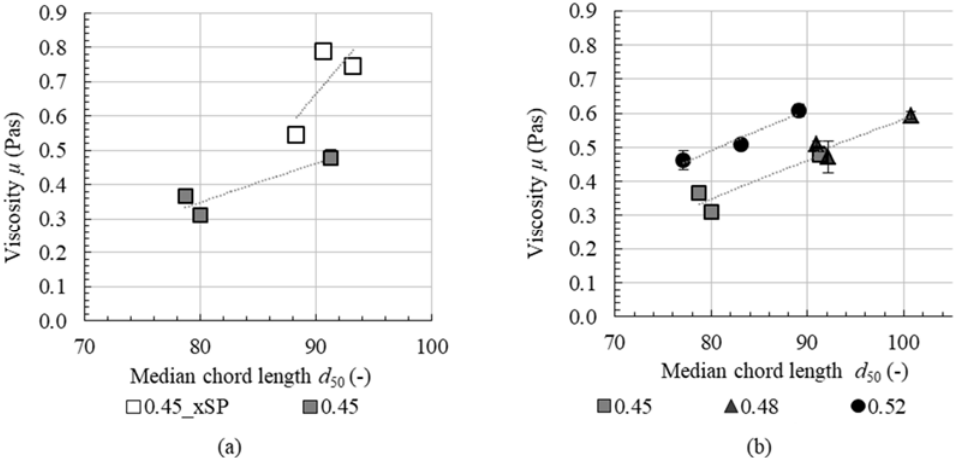
Figure 10. Correlation of the median chord length d 50 and viscosity for pastes with and without superplasticizer ( a ) and different solid volume fractions ( b ).